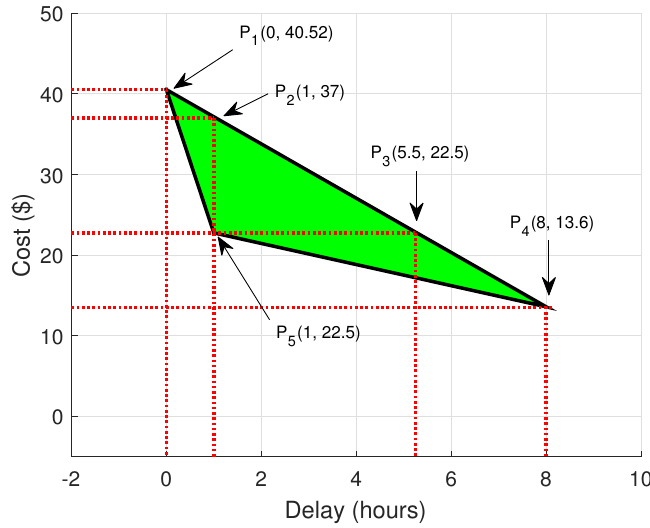
Figure 9. Feasible region of